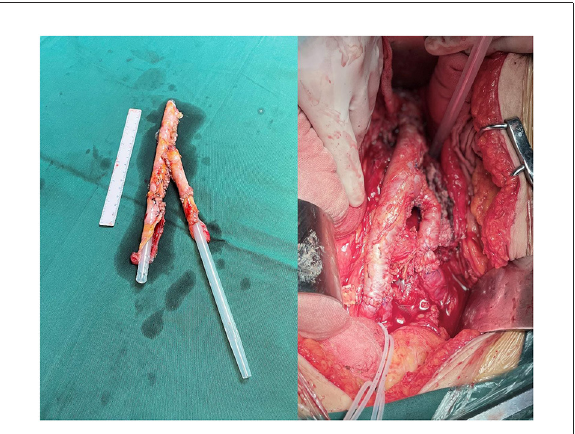
FIGURE1 Autologous fascia-peritoneum with a posterior rectus sheath was sutured for bifurcated